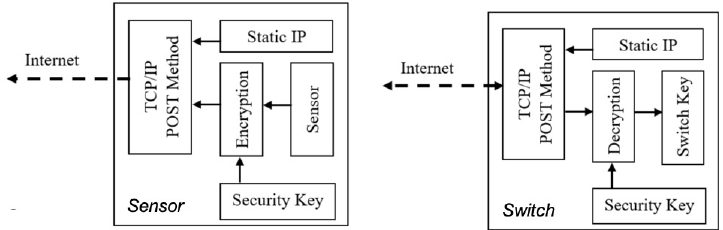
Figure 2. The scheme of sensors and switches.